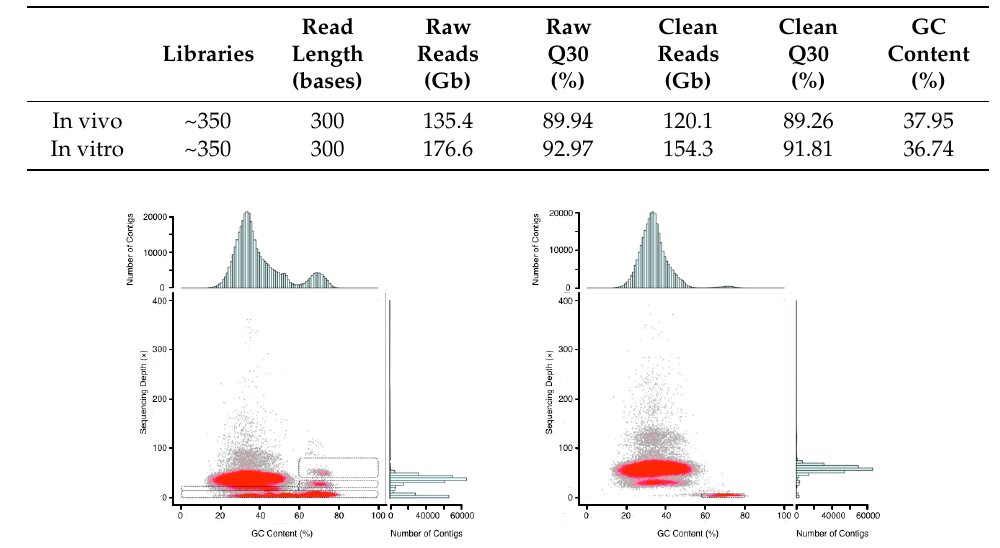
Table 2. Statistics for the sequencing data.